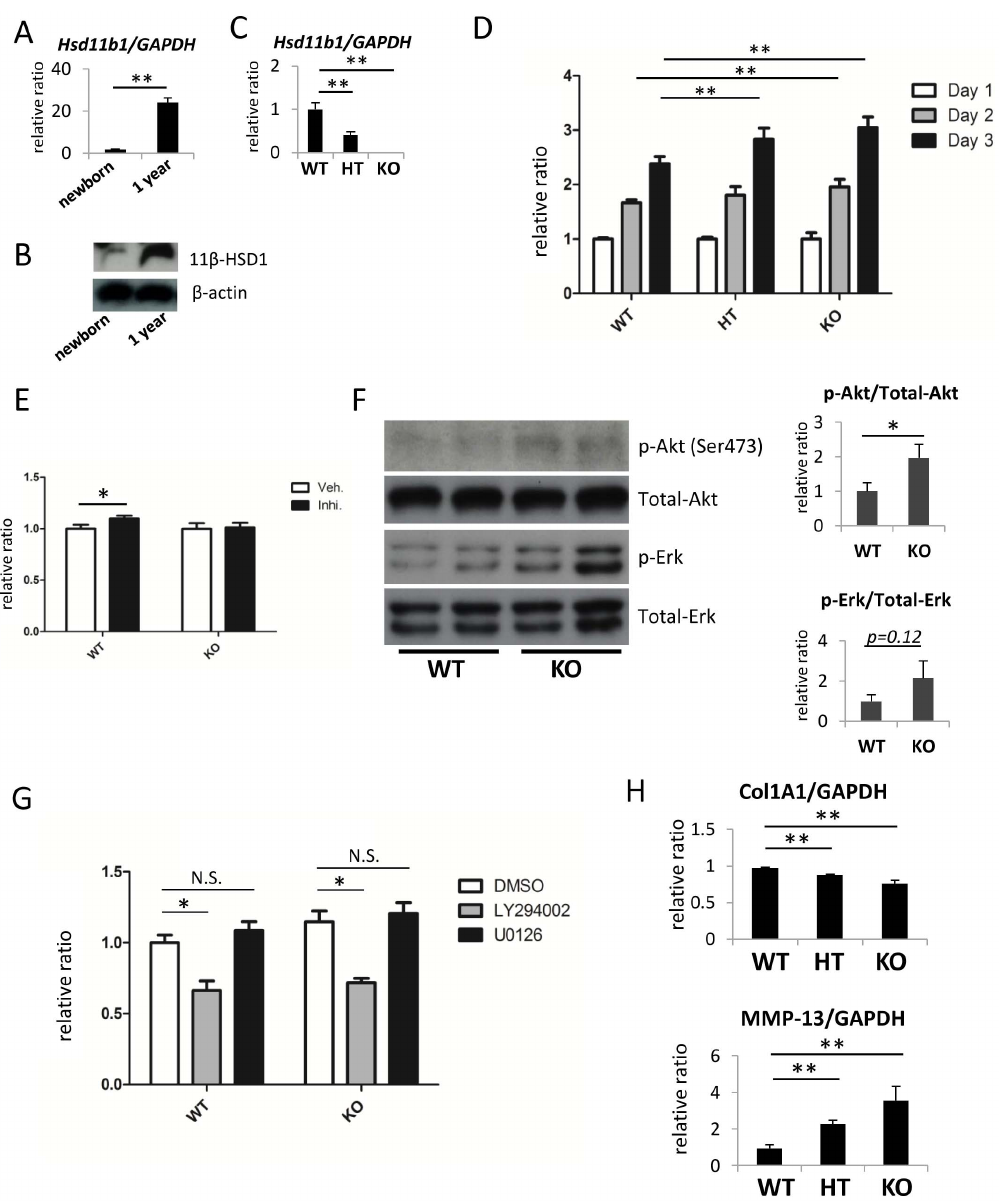
Figure 4. Proliferation and expression of a collagen-associated gene in 11 b -HSD1 knockout mouse dermal fibroblasts. (A) The relative expression of 11 b -HSD1 in dermal fibroblasts derived from newborn mouse skin and 1-year-old mouse skin was assessed with rtPCR. GAPDH was used as an internal control (N=3; **P , 0.01, Student’s t-test). (B) The expression of 11 b -HSD1 in dermal fibroblasts derived from newborn mouse skin and 1-year-old mouse skin was assessed with Western blotting. (C) The relative expression of 11 b -HSD1 in dermal fibroblasts derived from wild- type (WT), heterozygous knockout (HT), and homozygous knockout (KO) mouse skin was assessed with rtPCR. GAPDH was used as an internal control (N=3). **P , 0.01, one-way ANOVA followed by the Bonferroni-Dunn test for multiple comparisons. (D) Proliferation of dermal fibroblasts derived from WT, HT, and KO mice was assessed with an MTS assay on days 1, 2, and 3. Day 2 and 3 data were normalized to day 1 data for each group. Bars indicate the mean 6 SD [N=6; *P , 0.05, **P , 0.01, two-way ANOVA followed by the Bonferroni-Dunn test for multiple comparisons. There was also a significant interaction effect of genotype and time (F=13.33, P , 0.001)]. (E) Proliferation of dermal fibroblasts derived from WT mice treated with 11 b - HSD1 selective inhibitor (10 m M) for 3 days was assessed by MTS assay. DMSO was applied as vehicle control. Inhibitor group data were normalized to vehicle group. Bars indicate the mean 6 SD (N=10; *P , 0.05 Student’s t-test). (F) Western blot analysis of phospho-Akt (Thr308 and Ser473), Akt, phospho-Erk, and Erk in dermal fibroblasts derived from WT and KO mice. Bars show the results of densitometric analysis relative to b -actin. Mean 6 SD of each group are shown. (N=4, *P , 0.05, Student’s t-test) (G) The MTS assay was used to assess proliferation of dermal fibroblasts derived from WT and KO mice treated with an Akt inhibitor (LY294002, 10 m M) or an Erk inhibitor (U0126, 10 m M). Bars indicate the mean 6 SD (N=6; *P , 0.0001, two-way ANOVA followed by the Bonferroni-Dunn test for multiple comparisons.) (H) The relative expression of Col1A1 and MMP-13 in dermal fibroblasts derived from WT, HT, and KO mice. GAPDH was used as an internal control (N=3; **P , 0.01, one-way ANOVA followed by the Bonferroni- Dunn test for multiple comparisons).